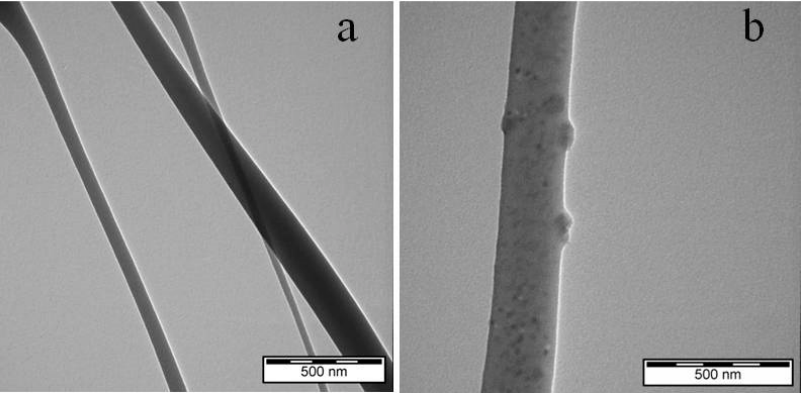
Figure 3. Representative TEM micrograph of electrospun plain PCL ( a ) and PCL/12% N ( b ) fibrous membranes.